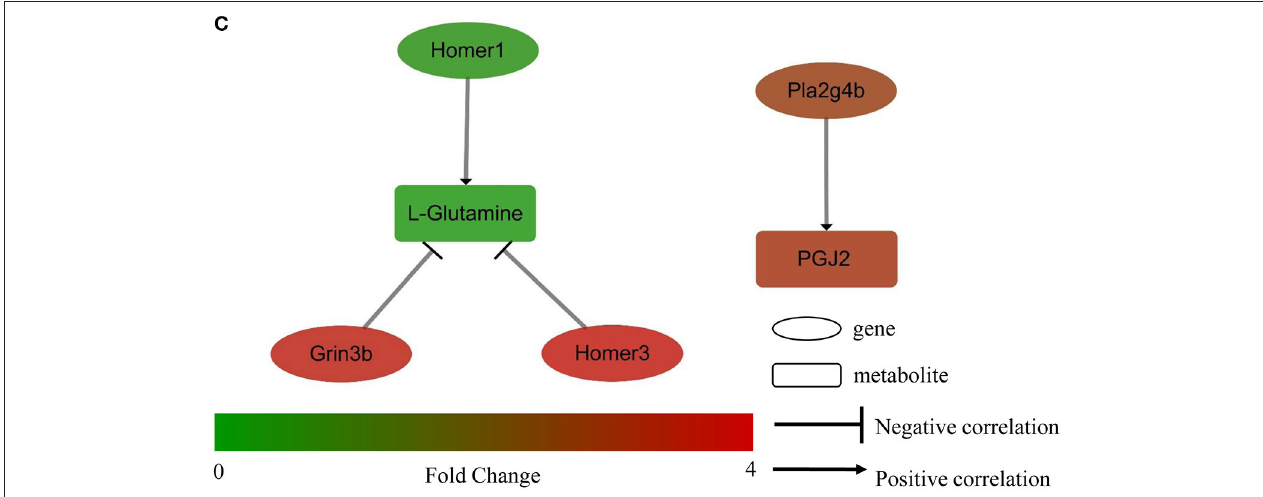
FIGURE 6 | Conjoint analysis of transcriptome and metabolome in mice brain tissues of CK and HD group. (A) KEGG pathway enrichment of differential genes and metabolites. (B) Heatmap of correlation coefficient matrix between differential metabolites and differential genes with the Pearson correlation coefficient above 0.8. Red and green indicated the positive and negative correlation, respectively. The color labels represent Pearson correlation coefficient values. (C) Regulating network between the genes and metabolites in sleep-related pathways. Differences in expression levels between the HD and CK groups was indicated by different colors, with green indicating down-regulation and red indicating